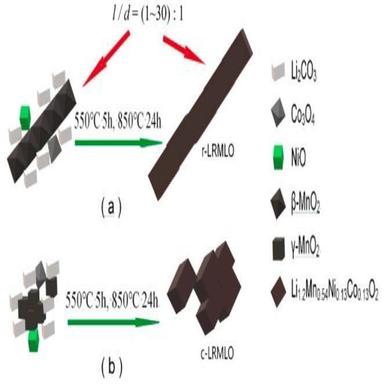
Synthetic procedure of r-LRMLO (a) with rod-like β-MnO2 and c-LRMLO (b) with γ-MnO2, respectively.